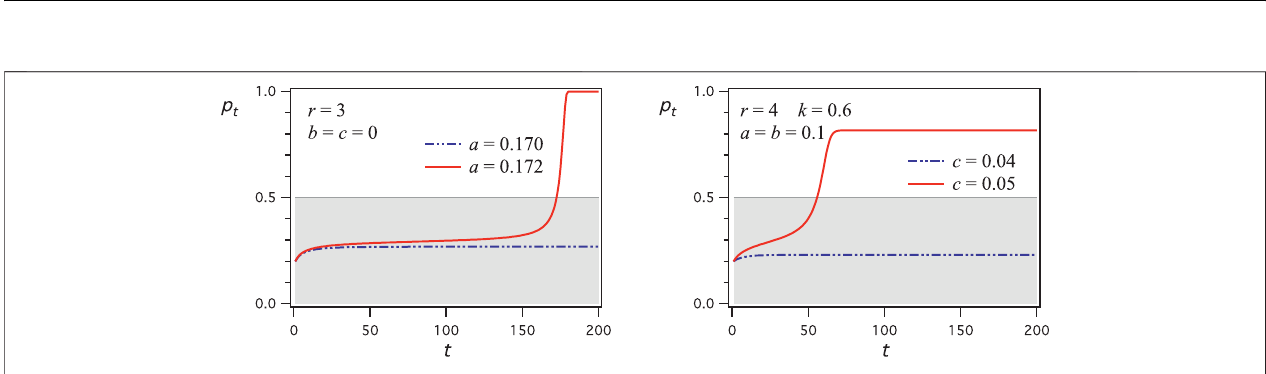
FIGURE4| Evolution of p , the proportion ofthe support for A, asafunction ofthe number ofupdates t . Left: A r (cid:2) 3case with startingvalue p (cid:2) 0 . 2. Two lines are those of a (cid:2) 0 . 170 and a (cid:2) 0 . 172, and common values b (cid:2) c (cid:2) 0. Right: A r (cid:2) 4 case with starting value p (cid:2) 0 . 2. Two lines are those of c (cid:2) 0 . 04 and c (cid:2) 0 . 05, and common values a (cid:2) b (cid:2) 0 . 10 and k (cid:2) 0 . 6.